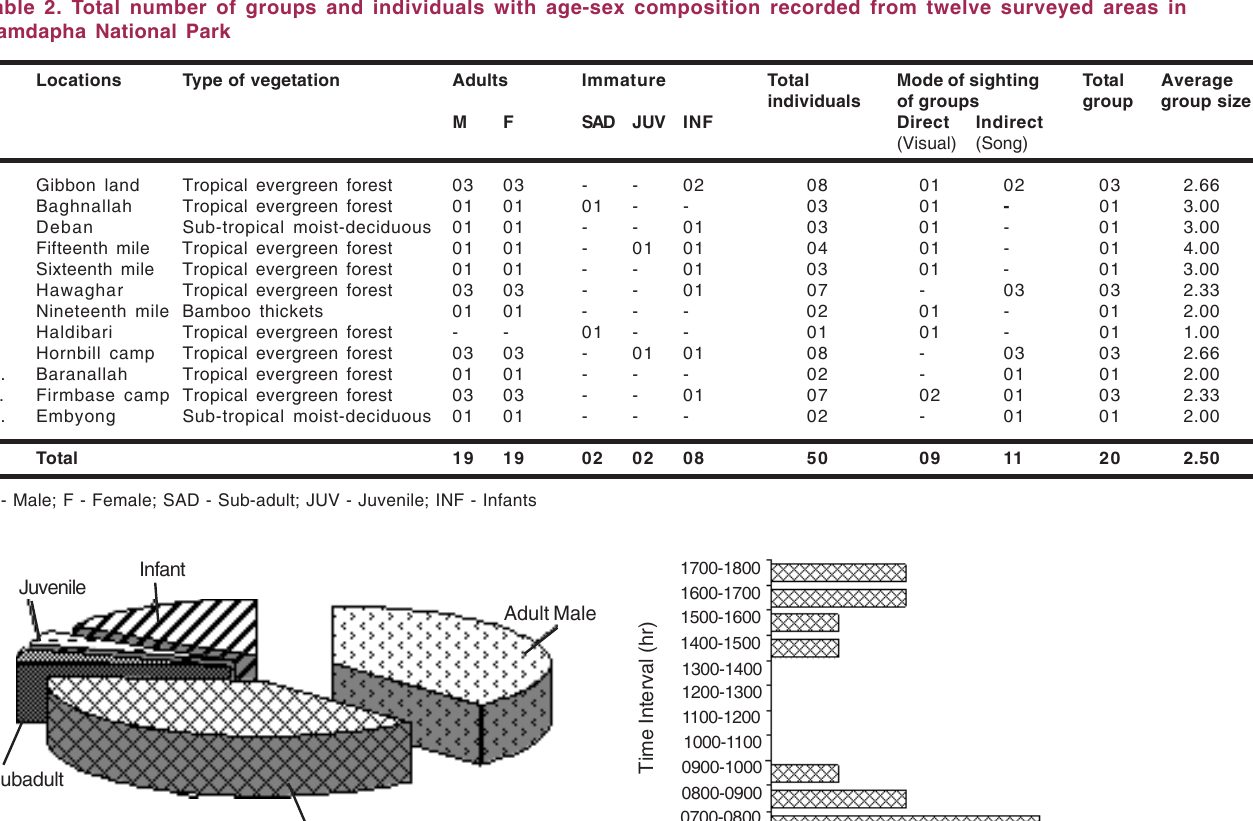
Southeastern Inside the Park (02)